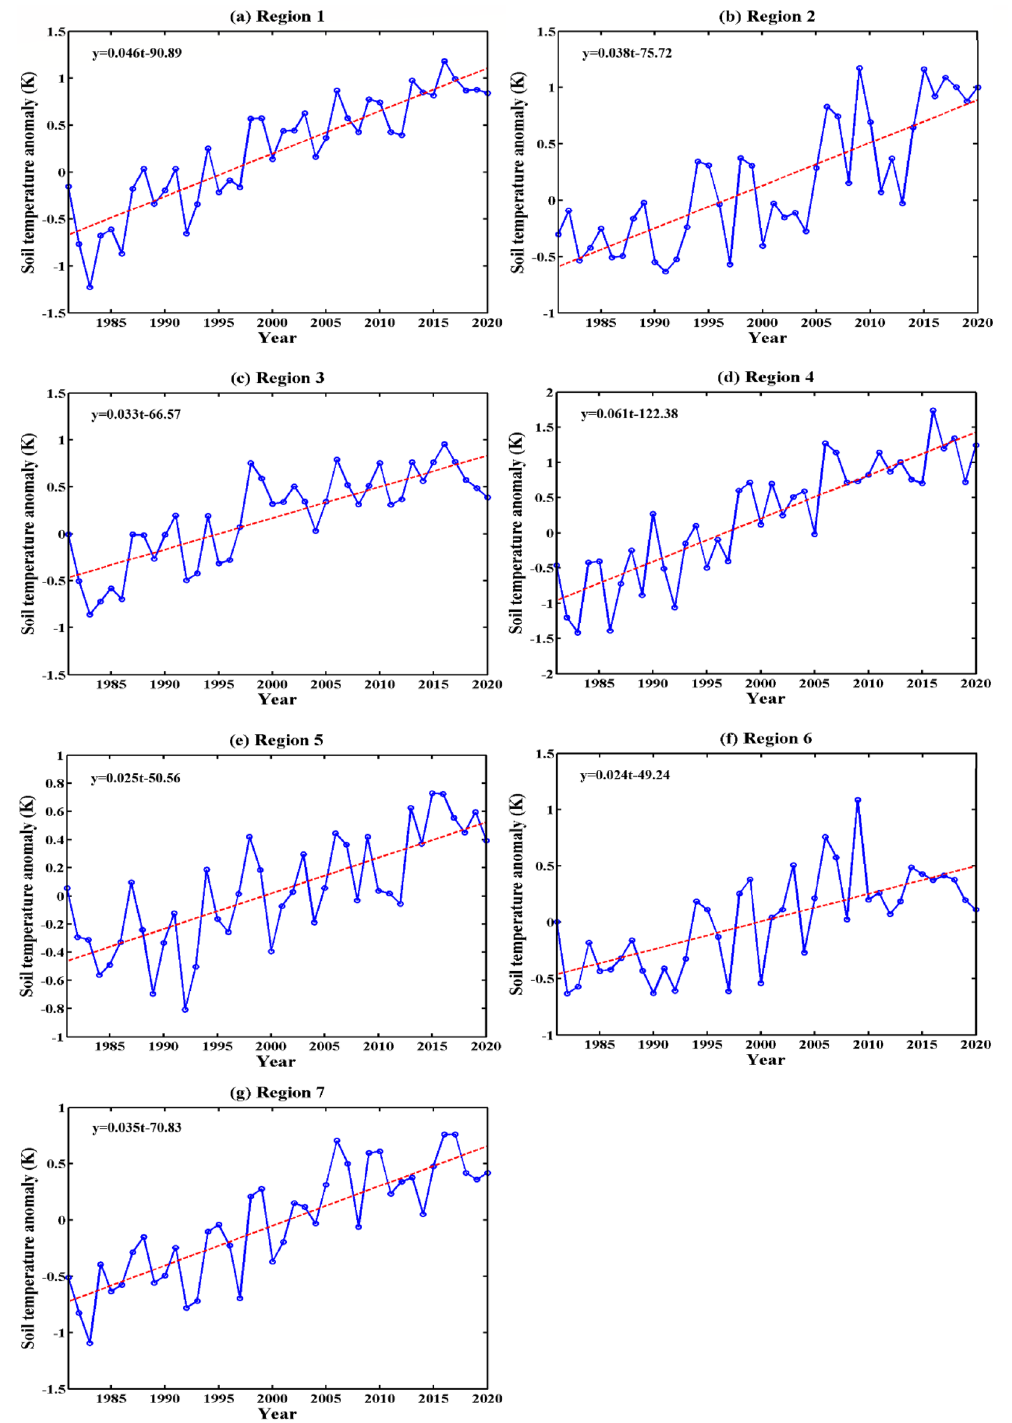
Figure 9. Interannual variation in the 20-cm ST anomalies in 7 regions of the Qinghai-Tibet Plateau (unit: K, α = 0.01